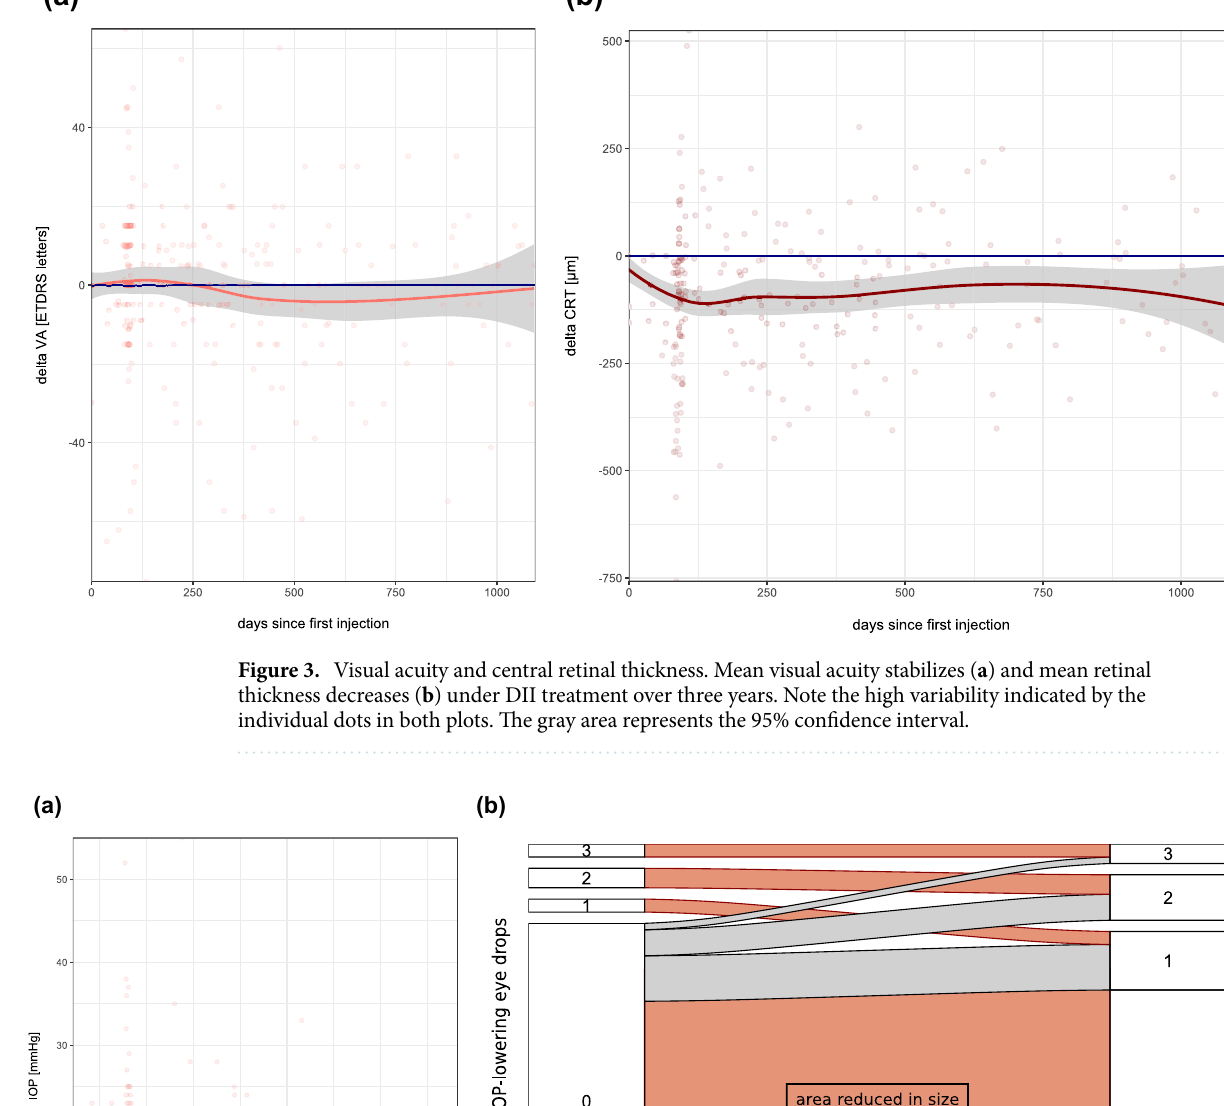
Figure 4. Intraocular pressure and IOP-lowering medication. Mean intraocular pressure ( a ) showed a slight increase around 4 weeks after initiation of DII treatment but remained between 15 and 20 mmHg at all time points. Individual eyes, however, showed significantly higher IOP levels. The use of IOP-lowering medication ( b ) remained relatively stable over time with more than 75% of patients not requiring IOP-lowering medication in all three